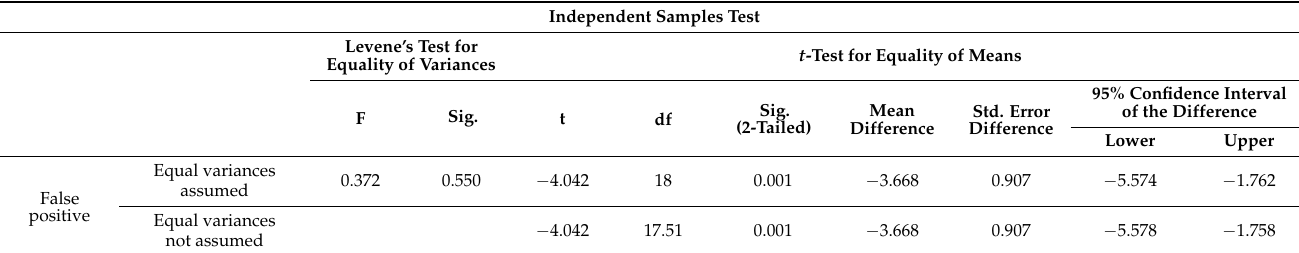
Table 10. Comparison of independent samples t -test parameters of EDRL and CNN algorithms for false positive.